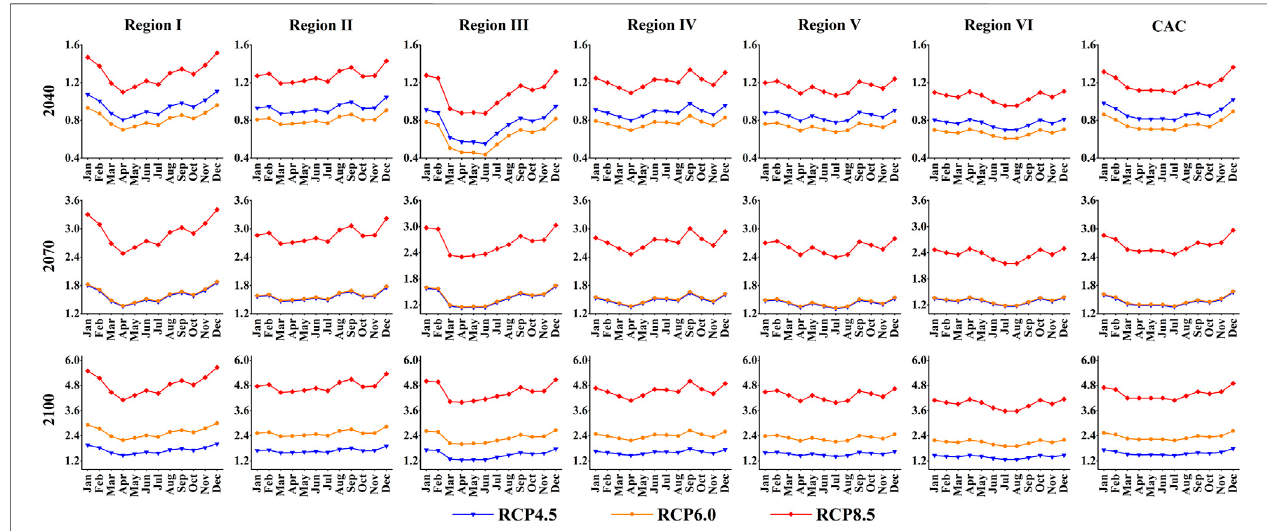
FIGURE 10 | Changes in monthly average Tmax for 2040, 2070, and 2100 with different RCPs relative to the base period 1996 – 2018 over CAC.